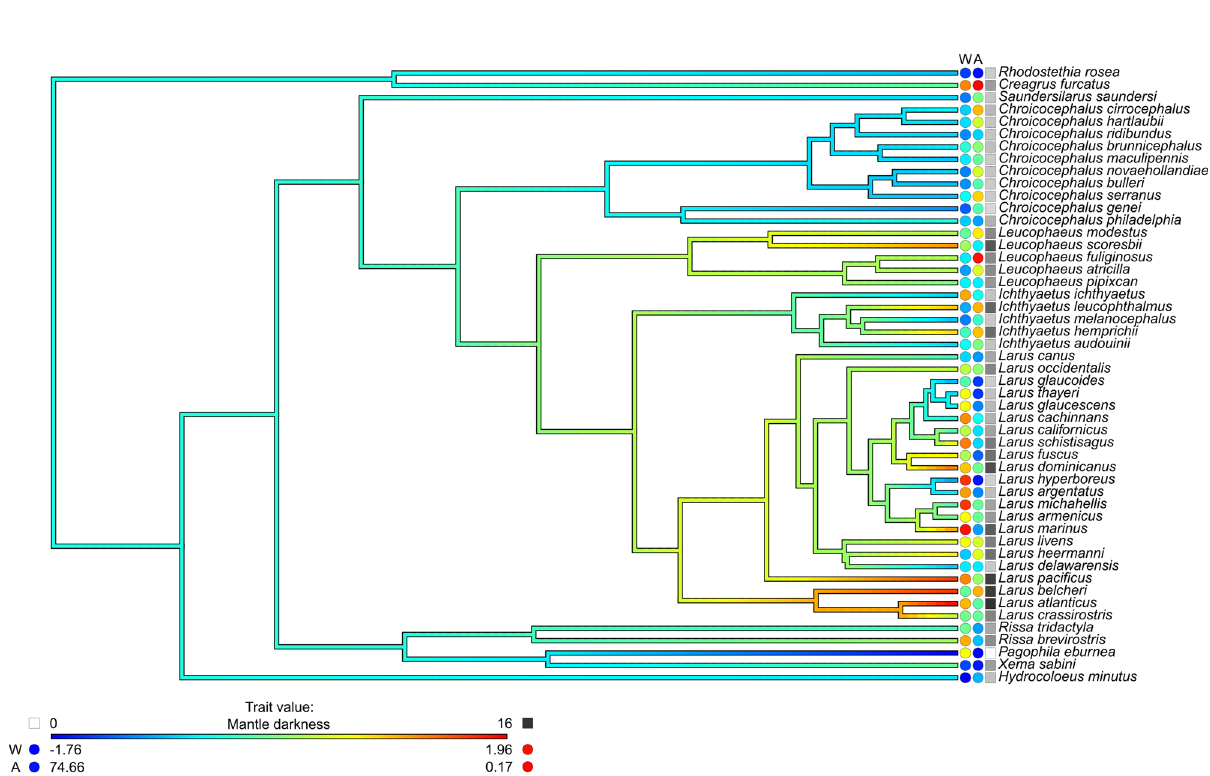
Fig. 1 The evolution of mantle darkness in the Larinae and its relationship with wing loading and absolute latitude. Branches show the estimated ancestral states of mantle darkness, with the current, observed states at the tips. The relative values of standardized wing loading (W) and absolute latitude (A, distance from the equator in degrees) are shown by coloured circles, along with the approximate mantle darkness of each species on the Kodak grey scale (squares). The height of the phylogenetic tree is 0.21 million years. Note: genus names of the original BirdTree phylogeny have been amended to re fl ect current nomenclature.